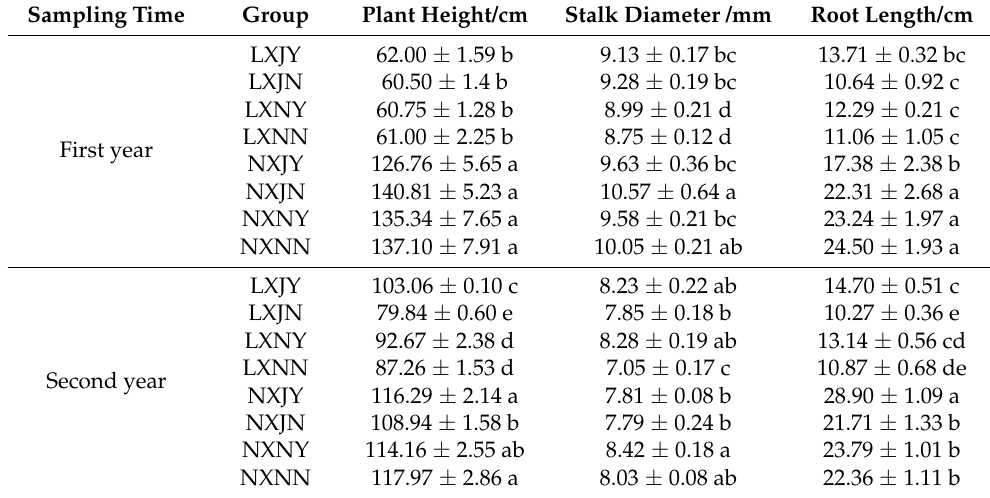
Table 1. The growth index of sunflower in two consecutive years under different treatments. Sampling